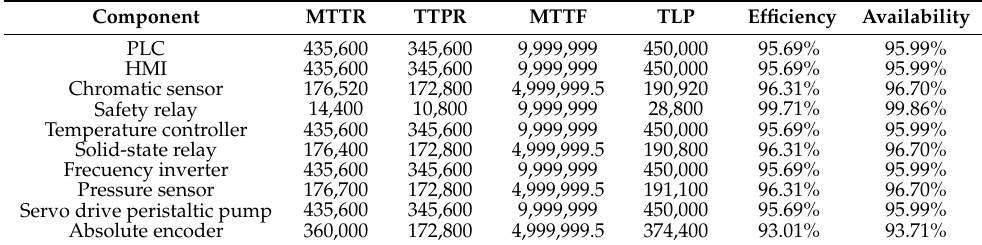
Table 7. Electronic components times in seconds. Efficiency and availability calculated in % with PPM strategy.